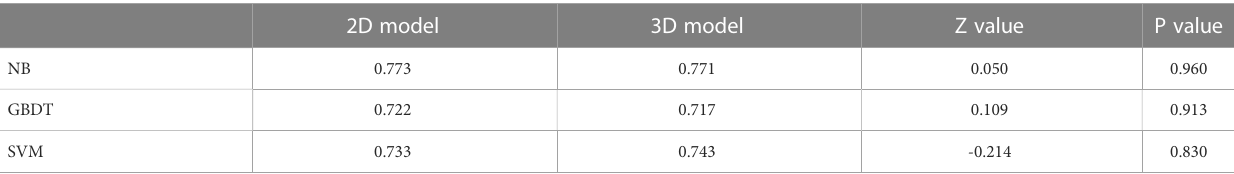
TABLE 3 The AUCs of different methods and results of Delong text.